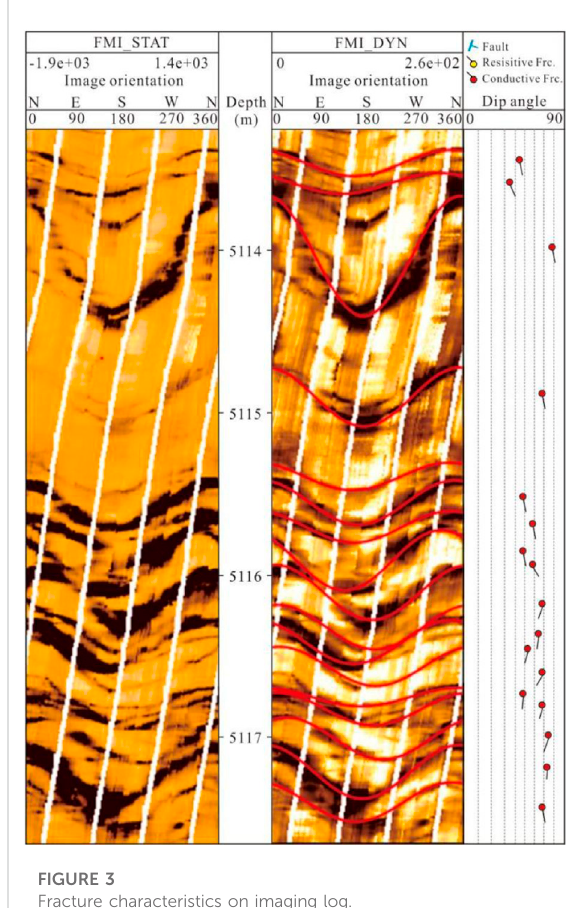
FIGURE 3 Fracture characteristics on imaging